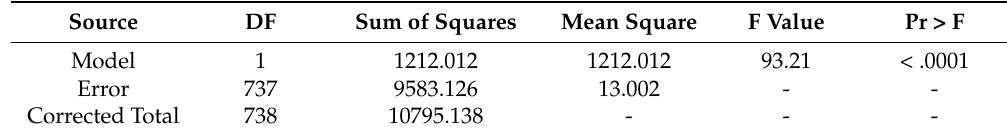
Table 16. ANOVA table for stem length.